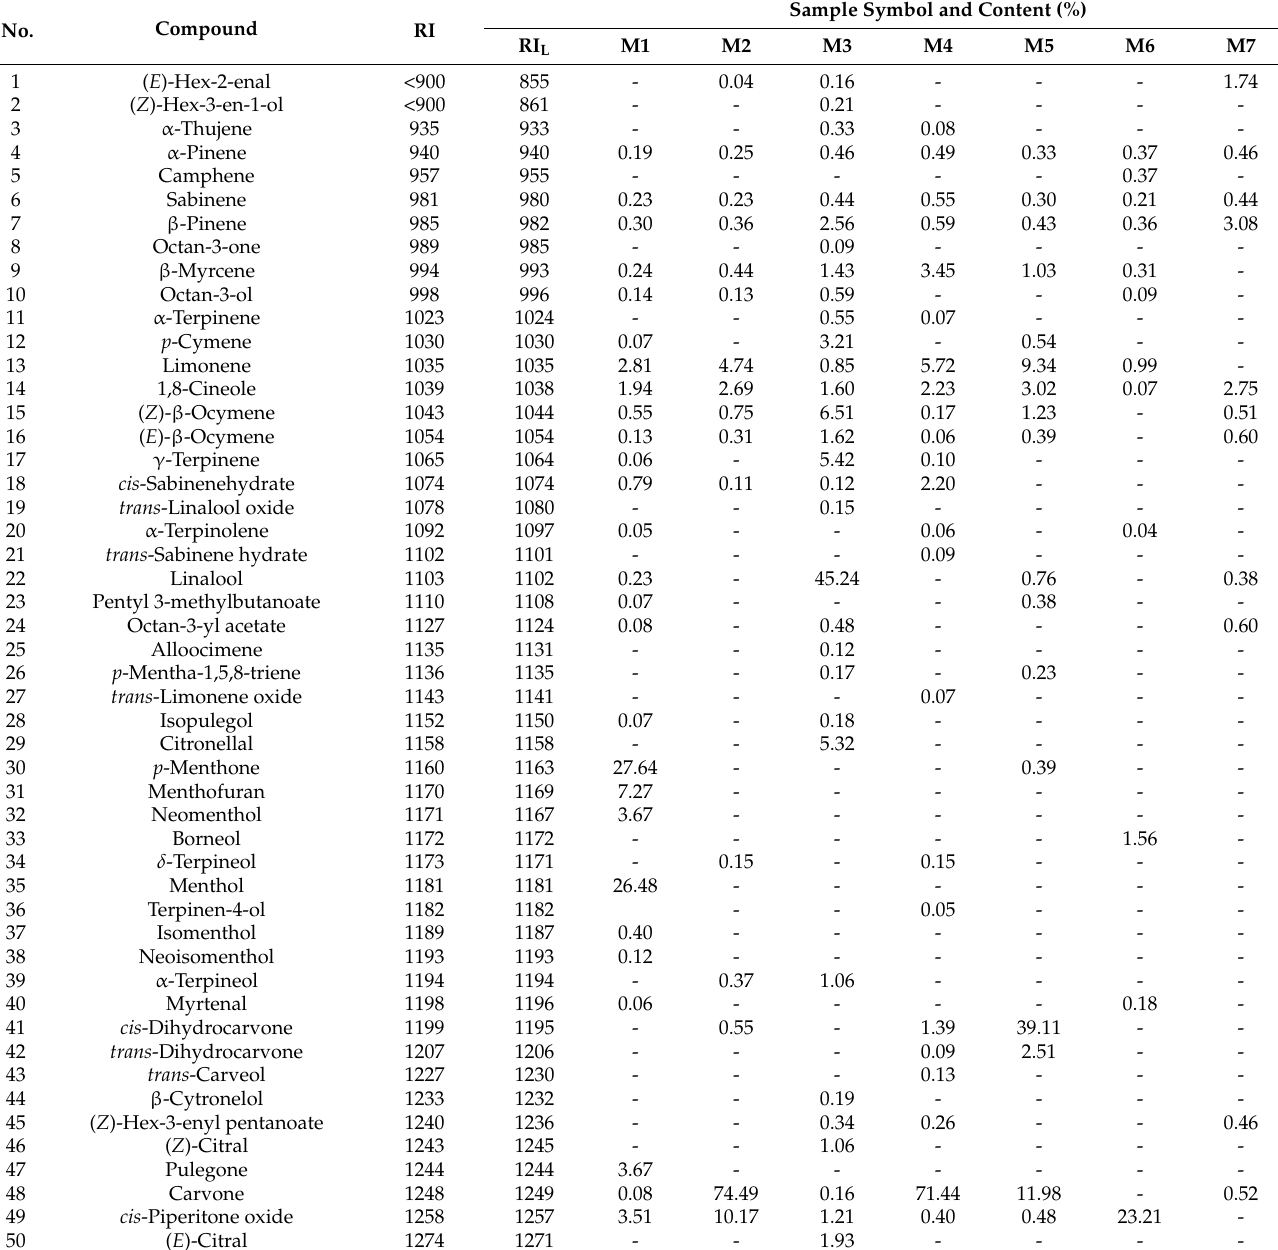
Table 2. Volatile component composition (peak area%) obtained using HS-SPME method and their amount in Mentha